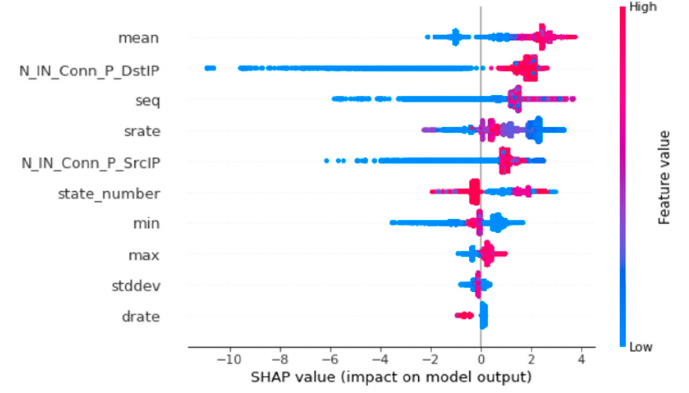
Figure 6. SHAP summary plot.